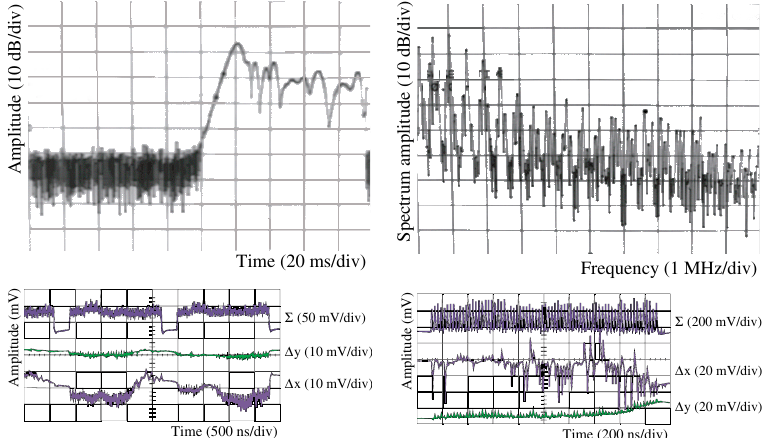
(cid:6) 5 : 5 (cid:1) 10 10 p = b . The signal obtained via a FIG. 11. (Color) Instability footprint for N b spectrum analyzer with zero frequency span and central frequency of 357 kHz is shown in the upper left panel. A Fourier analysis from 0–10 MHz is shown in the upper right panel. In the lower part, the signals from a pickup in the PS ring some tens of milliseconds before extraction (left panel) and the TT2 transfer line (right panel) are